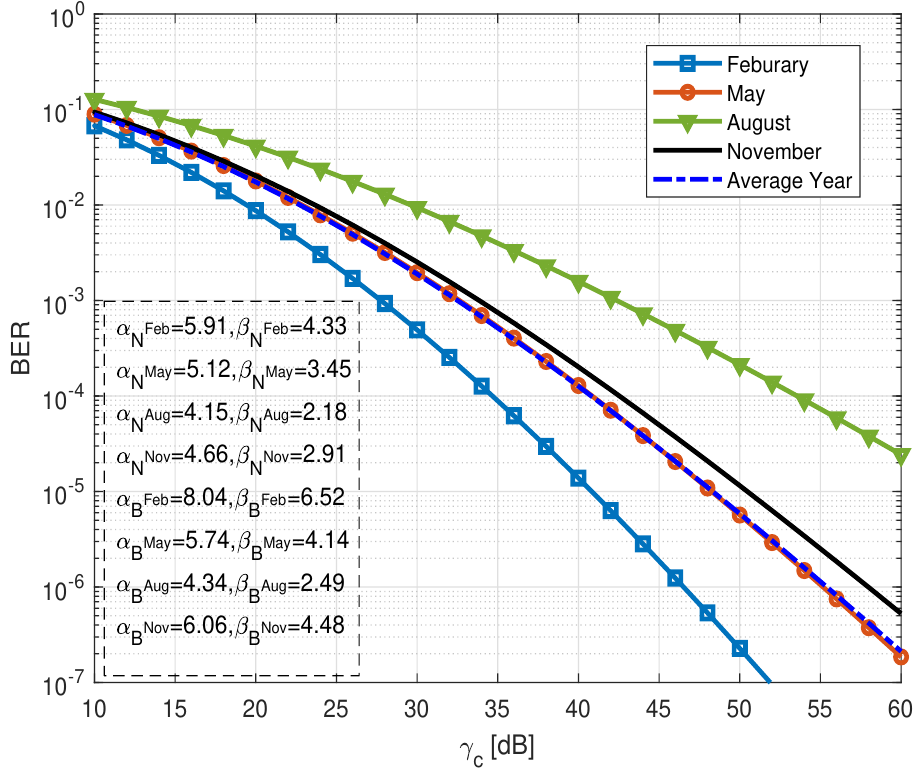
Figure 5. The combined observation of BER performance in both of the oceans through out the year quarterly. Where the maximum and lowest BER performance are depicted in Feb and August within the critical temperature and salinity,